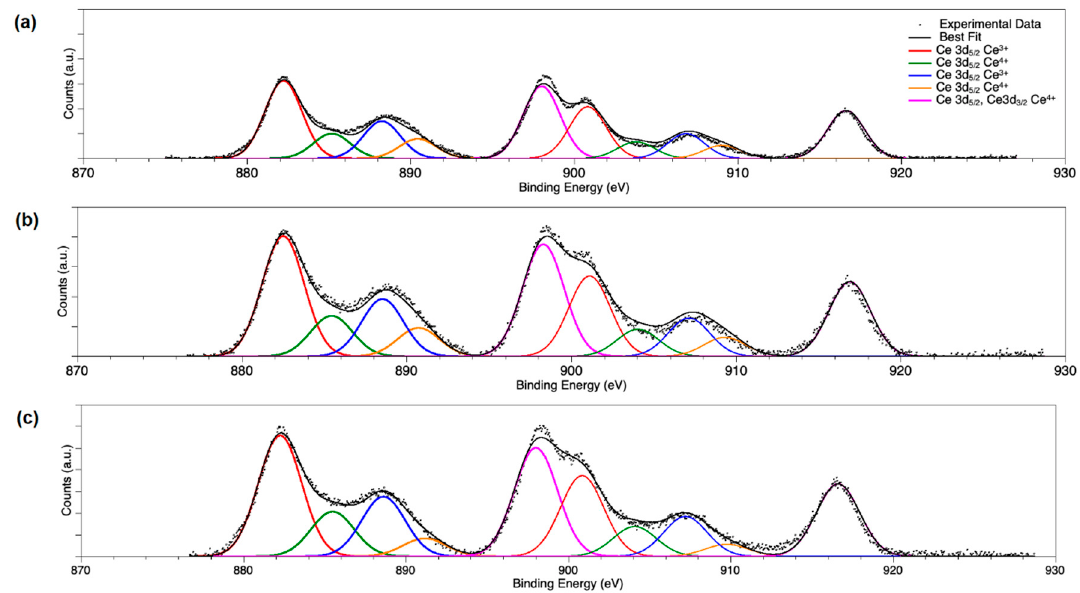
Figure 5. X-ray photo electron spectroscopy (XPS) spectra of Ce 3d region for the samples: ( a ) CeO 2 -NR, ( b ) PdO x /CeO 2 -NR, and ( c ) PdO x /CeO 2 -NR-Red. All Ce 3d 5/2 spin-orbit components, as well as the Ce 3d 3/2 peaks at higher BE (binding energy) values (diagnostic for the presence of Ce 4+ ions), appear as bold lines in the spectra. Table 2. Atomic percent values of palladium species in PdO x / CeO 2 -NR and PdO x / CeO 2 -NR-Red, collected from XPS